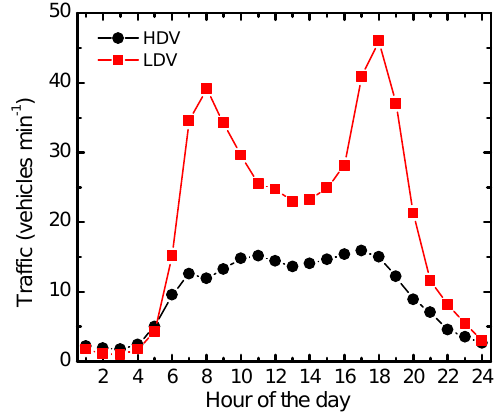
Fig. 4. Median values for vehicular traffic in the RA tunnel. Hour of the day in local time. No traffic congestions were observed in the RA tunnel during the studied period. The majority of HDVs in this tunnel are large trucks. LDVs are mostly flexible fuel vehicles. Motorcycles were not apportioned in this tunnel; however, due to its location (outside city limits), very few are expected to be found.